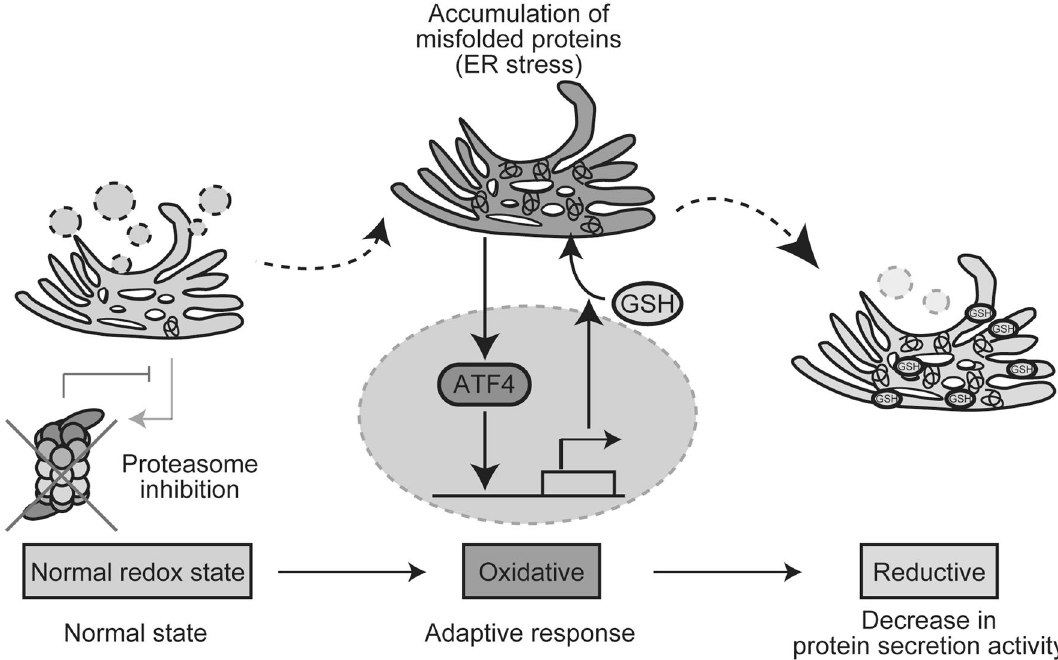
Figure 5. Schematic representation of the redox dynamics in the ER following proteasome inhibition. Proteasome inhibition induces accumulation of misfolded proteins in the ER, namely ER stress. Expression of ATF4 is increased to induce various genes containing glutathione metabolite genes, which causes increase of GSH influx to ER, ER reduction, and inhibition of protein